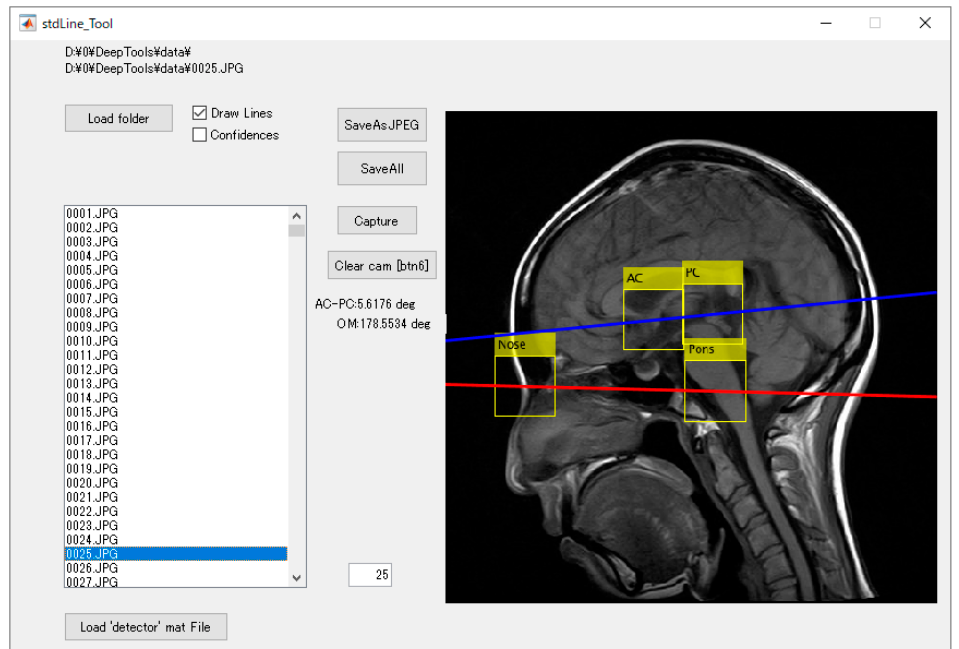
Figure 4. The detection software based on the created model and the delineation of the standard line for brain magnetic resonance imaging (MRI). The yellow bounding boxes represent automatically detected anatomy, the red line is the calculated orbitomeatal (OM)-line, and the blue line is the calculated anterior commissure–posterior commissure (AC-PC) line.